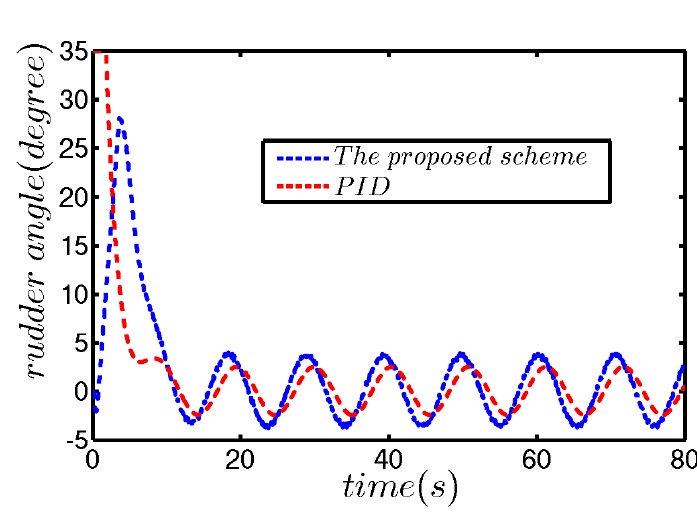
Figure 8. The curves of rudder angle under strong disturbance.